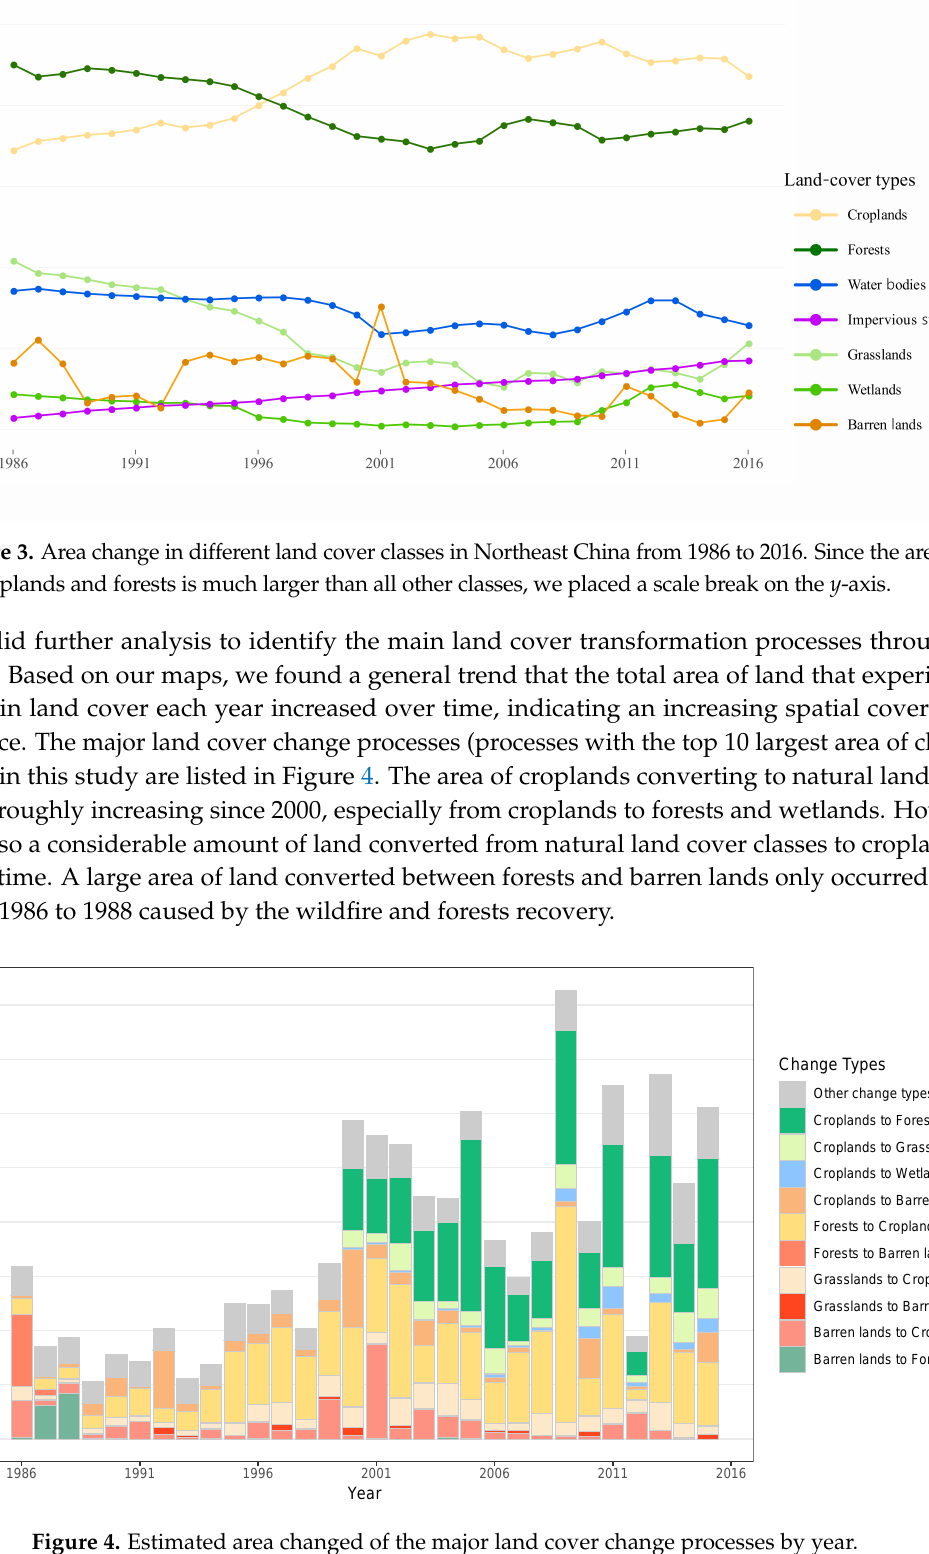
Figure 4. Estimated area changed of the major land cover change processes by